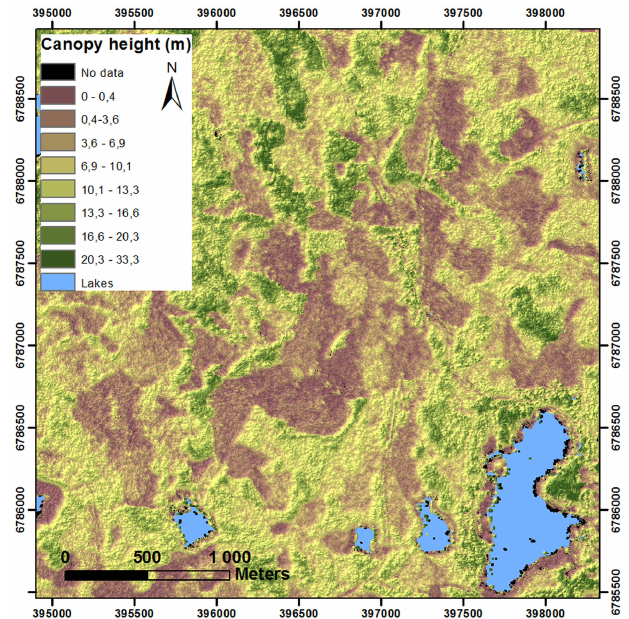
Figure 2. The airborne laser scanning (ALS)-based digital terrain model (DTM) of the Evo area ( cf. Figure 1) was subtracted from a digital surface model (DSM) derived from Tandem-X interferometric synthetic aperture radar (SAR) pair (29 June 2013) to get an InSAR canopy height model (CHM)